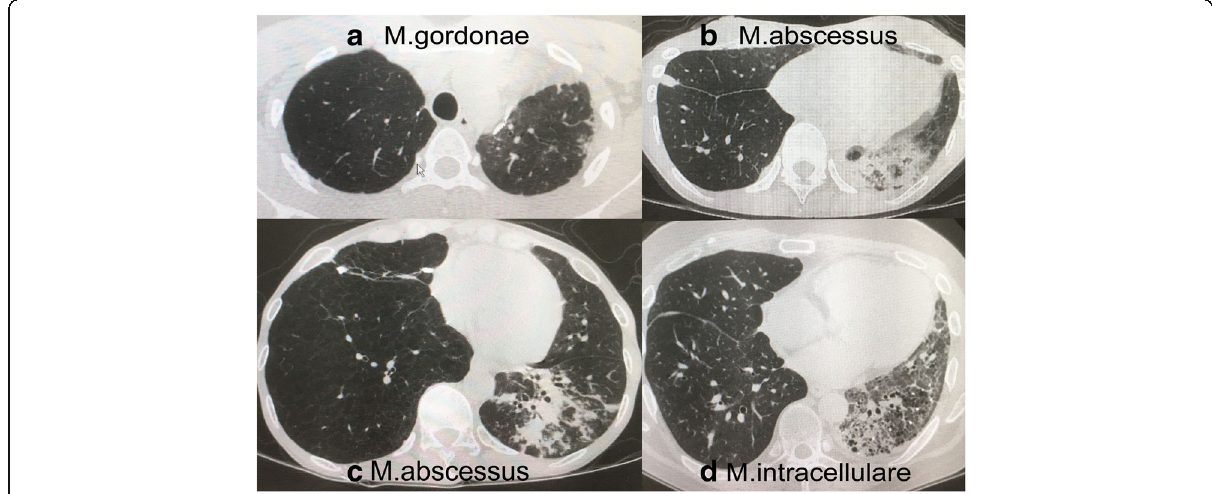
Fig. 1 a – d . Chest computed tomography showing consolidation. a Case 1, slight consolidation in left upper lesion caused by M. gordonae . b Case 2, consolidation in left lower lesion caused by M. abscessus . c Case 3, consolidation in transplanted lung caused by M. abscessus . d Case 4, consolidation in native lung caused by M.